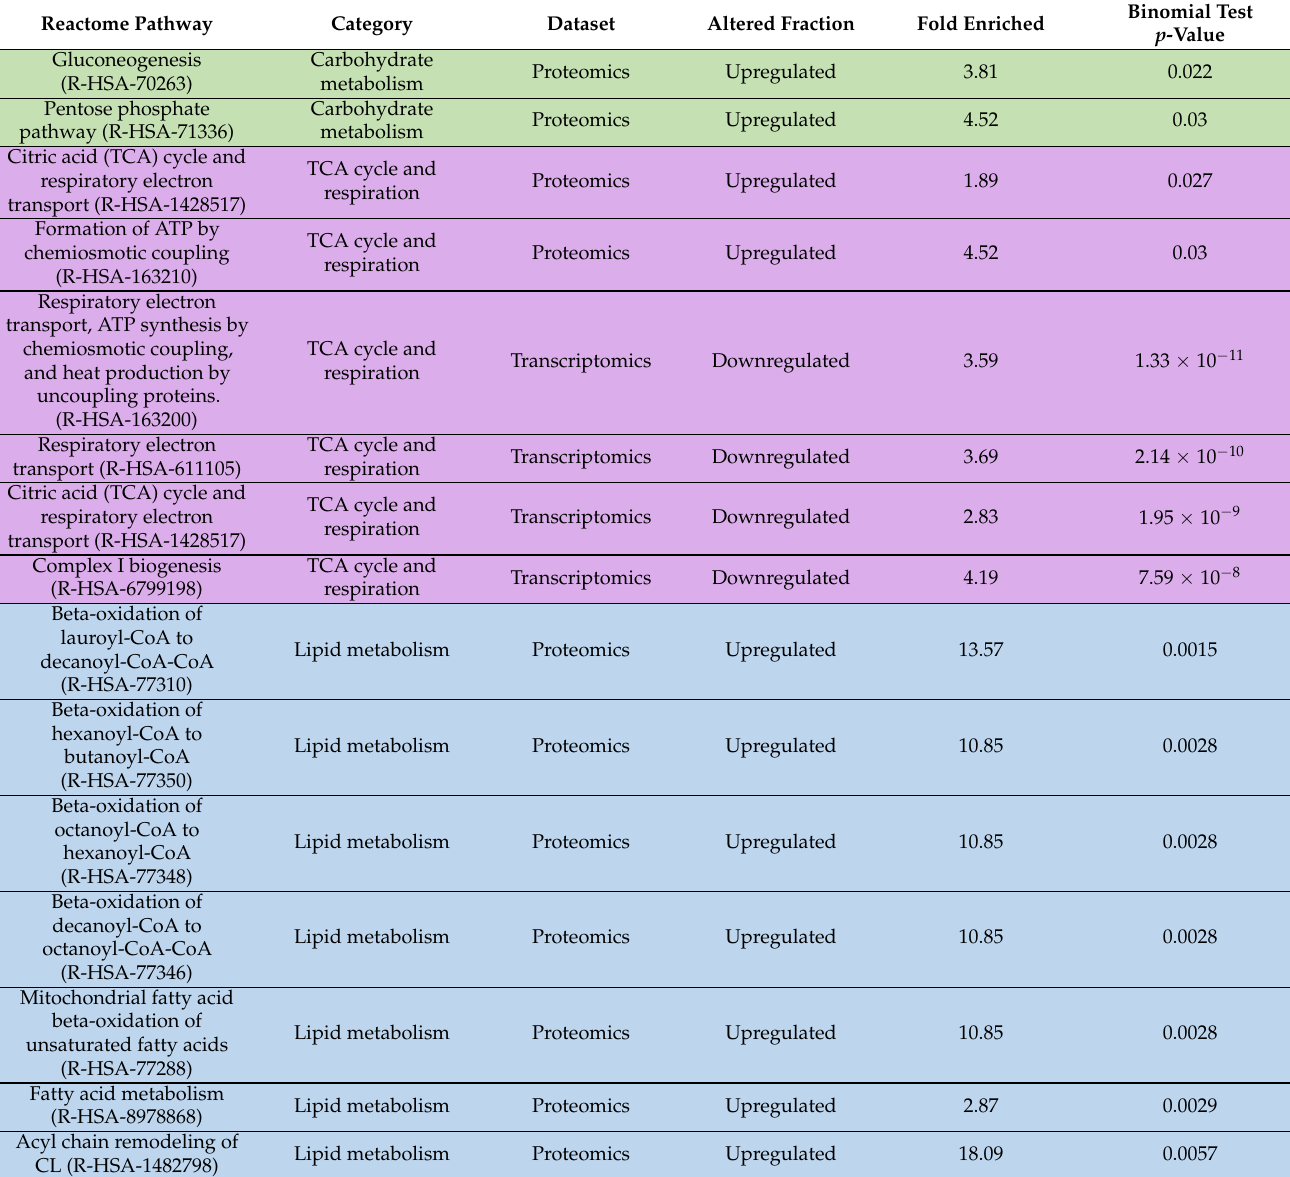
Table 1. Significantly altered mitochondrial, substrate-providing and related metabolic pathways of interest as indicated by PANTHER gene expression analysis of both the proteomic and transcriptomic datasets. “Reactome Pathway” was set as the level of biological granularity. Pathways were categorized and colour-coded by areas of most interest to this investigation as follows: green for carbohydrate metabolism, purple for the TCA cycle and respiration, blue for lipid metabolism, red for amino acid metabolism, yellow for protein degradation, cyan for other mitochondrial, and grey for transport of substrate